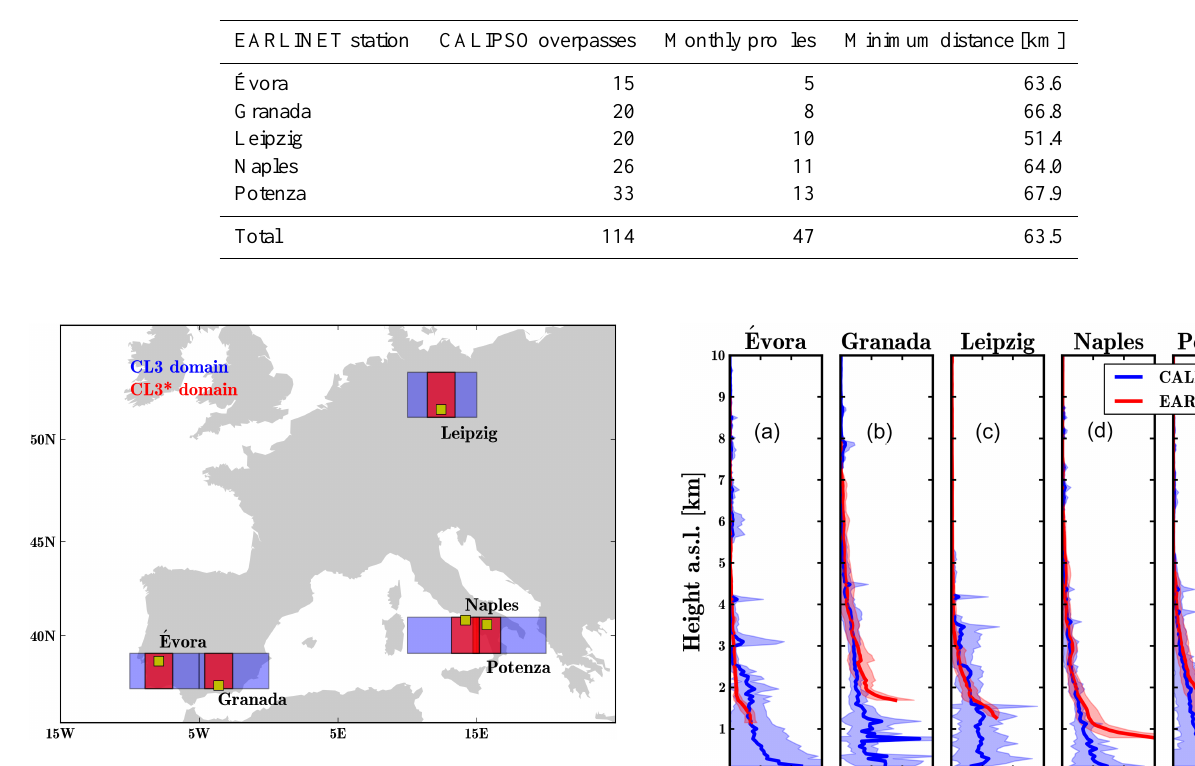
Figure 2. Spatial boundaries of the CALIPSO data that are related to the five EARLINET sites. The alternative CL3 ∗ domain reflects the finer spatial resolution with regard to the CL3 domain. The CL3 ∗ grid cell is dictated by the correlative measurements sched- ule (measurements are triggered when the satellite’s ground track is within 100km distance from the station); the latitude borders of the grid are kept equal to the CL3 grid.